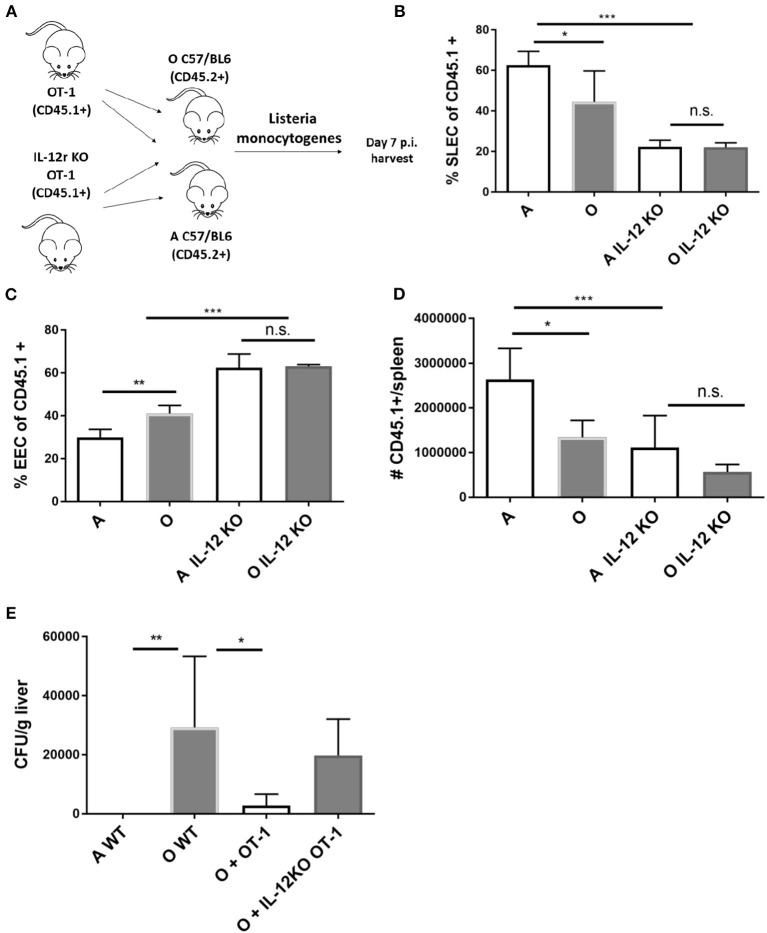
IL-12 KO OT-1 cells are equally dysfunctional in the old and adult priming environment. (A) Five thousand naïve IL-12R KO OT-1 CD8 T cells (CD45.1+) were transferred into adult and old mice C57/B6 (CD45.2+) mice (N = 5). Next day mice were inoculated intravenously (i.v.) with 104 CFU Lm-OVA. On day 8 p.i. mice were sacrificed (N = 5), splenic T cells were analyzed by flow cytometry. (B) IL-12R KO OT-1 cells showed equally poor differentiation into SLECs in adult and old mice and were (C) predominantly of EEC phenotype. (D) Expansion of Ag specific cells was decreased in animals which received IL-12R KO cells. (E) Transfer of OT-1 transgenic CD8 T cells into old mice resulted in decreased bacterial burden in the liver but not if the OT-1 cells were IL-12R KO (*p < 0.05, **p < 0.01, ***p < 0.001, ****p < 0.0001).